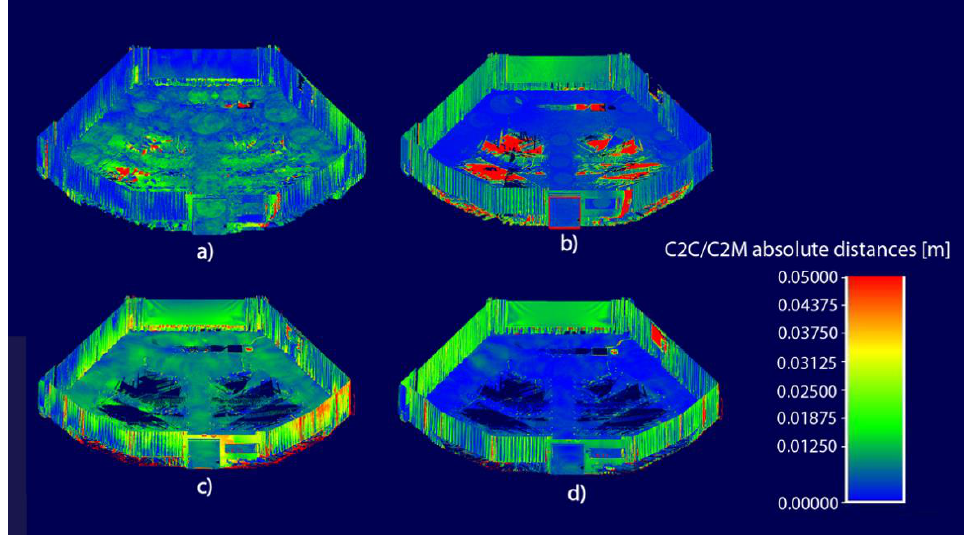
Figure 7. From the Tetra room geometry, C2C distances of the Matterport ( a ) and Matterport-processed BLK360 ( b ) point clouds; C2M distances of the Matterport ( c ) and BLK360 ( d ) meshes.